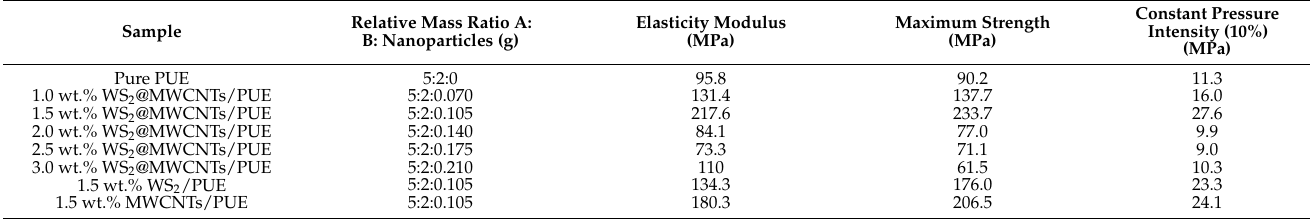
Table 1. Formulations of composite PUE and related static compression